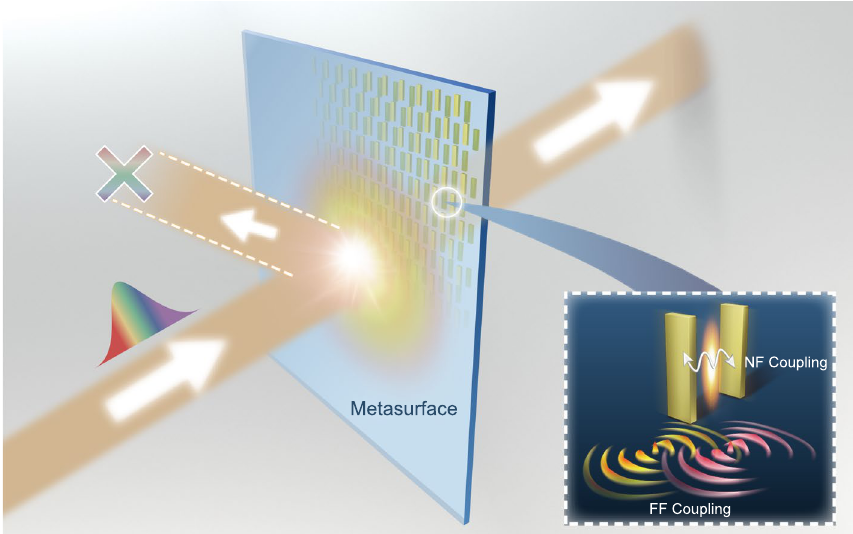
Fig. 1 Schematics of the achromatic reflectionless bi-layer metasurface. Tailoring near-field and far-field couplings between two optically identical resonators placed on different phase planes (inset), one can realize a metasurface that is immune from reflections at all frequencies below the first diffraction mode, yet with light power switched between transmission and absorption channels dictated by the intrinsic